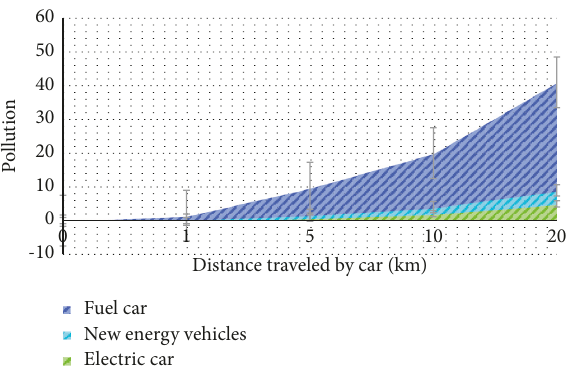
Figure 3: Analysis diagram of environmental pollution caused by three kinds of cars driving the same distance.